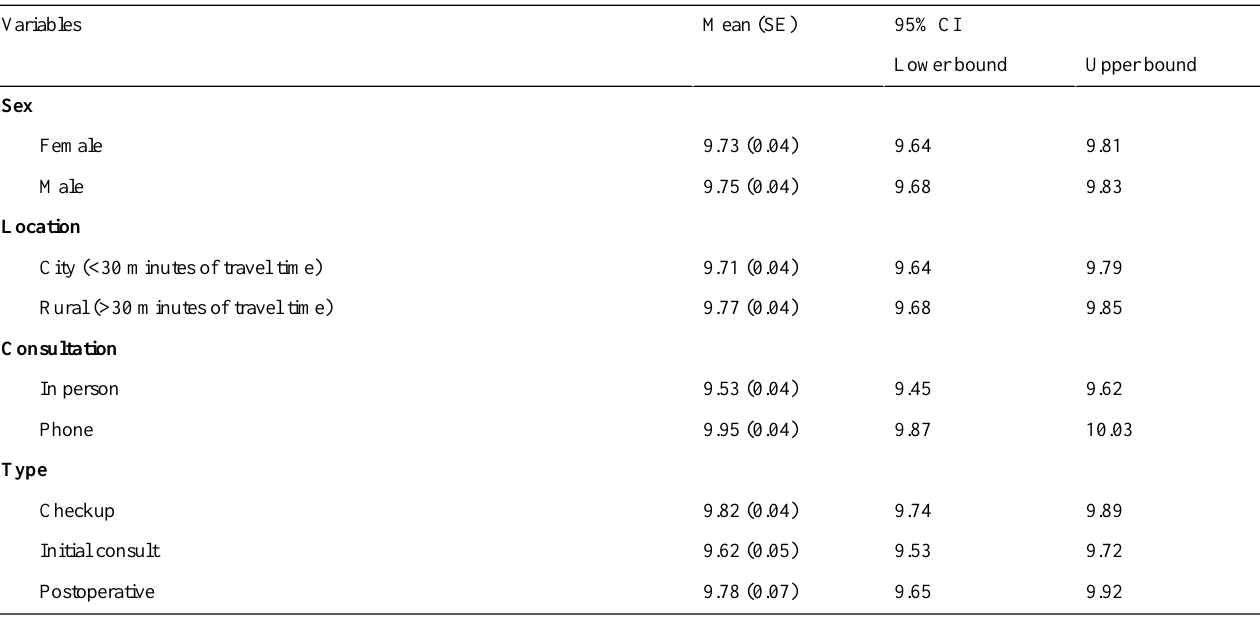
Table 2. Patient satisfaction (on a scale from 0-10, with 10 being the most satisfied) according to sex, location, consultation, and visit